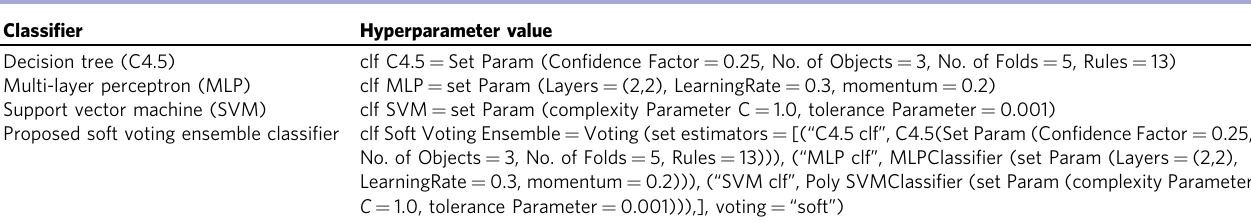
Fig. 6 The proposed soft voting ensemble architecture developed for automated assessment of adolescent delinquency. The base classi fi ers utilized are, C4.5 (Decision Tree), MLP and SVM. Table 4 Tuning hyperparameters for machine-learning